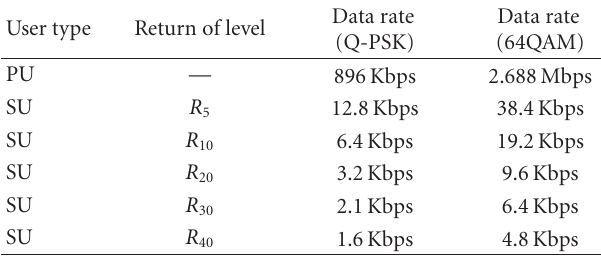
Table 2: Theoretical peak bit rates (PU and SU).